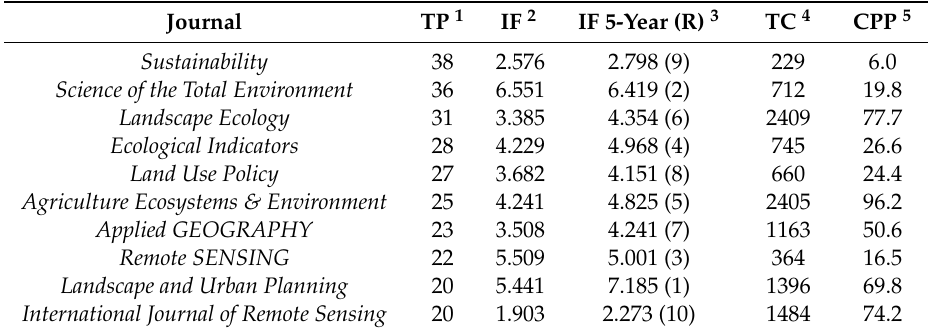
Table 5. The top 10 productive